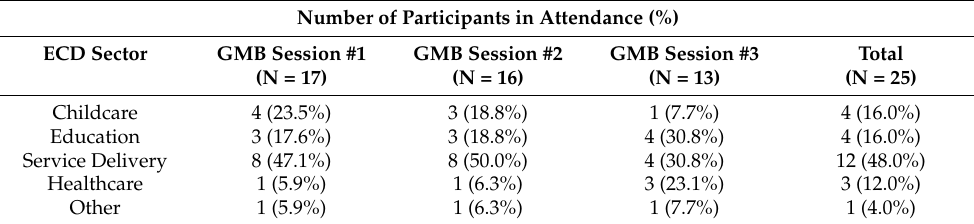
Table 1. Summary of participants at each group model building